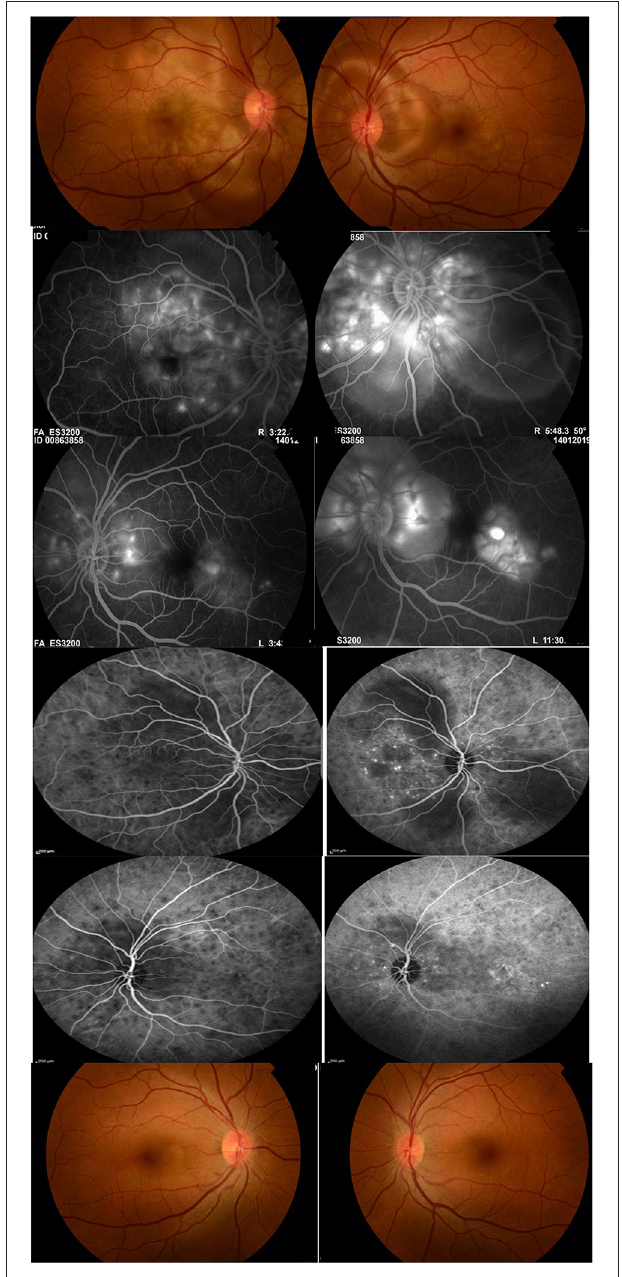
FIGURE 1 | A 36-year-old female with initial-onset acute uveitis associated with Vogt-Koyanagi-Harada disease at presentation. Visual acuity was 20/200 in the right eye and 20/60 in the left eye (first row). Fluoresceine angiography shows multiple pinpoint hyperfluorescent spots at the level of the retinal pigment epithelium, late pooling of dye in the areas of exudative retinal detachment (second and third rows). Indocyanine green angiography shows multiple hypofluorescent spots corresponding to choroidal granulomas, hypofluorescent patches corresponding to areas of exudative retinal detachment and punctate choroidal hyperfluorescence (fourth and fifth rows). The patient received systemic corticosteroids combined with mycophenolate mofetil. Twenty-six months after treatment, best visual acuity was 20/20 in both eyes. The patient was off treatment for 10 months without relapse of inflammation. Note the absence of “sunset glow fundus” and of chorioretinal atrophy (sixth